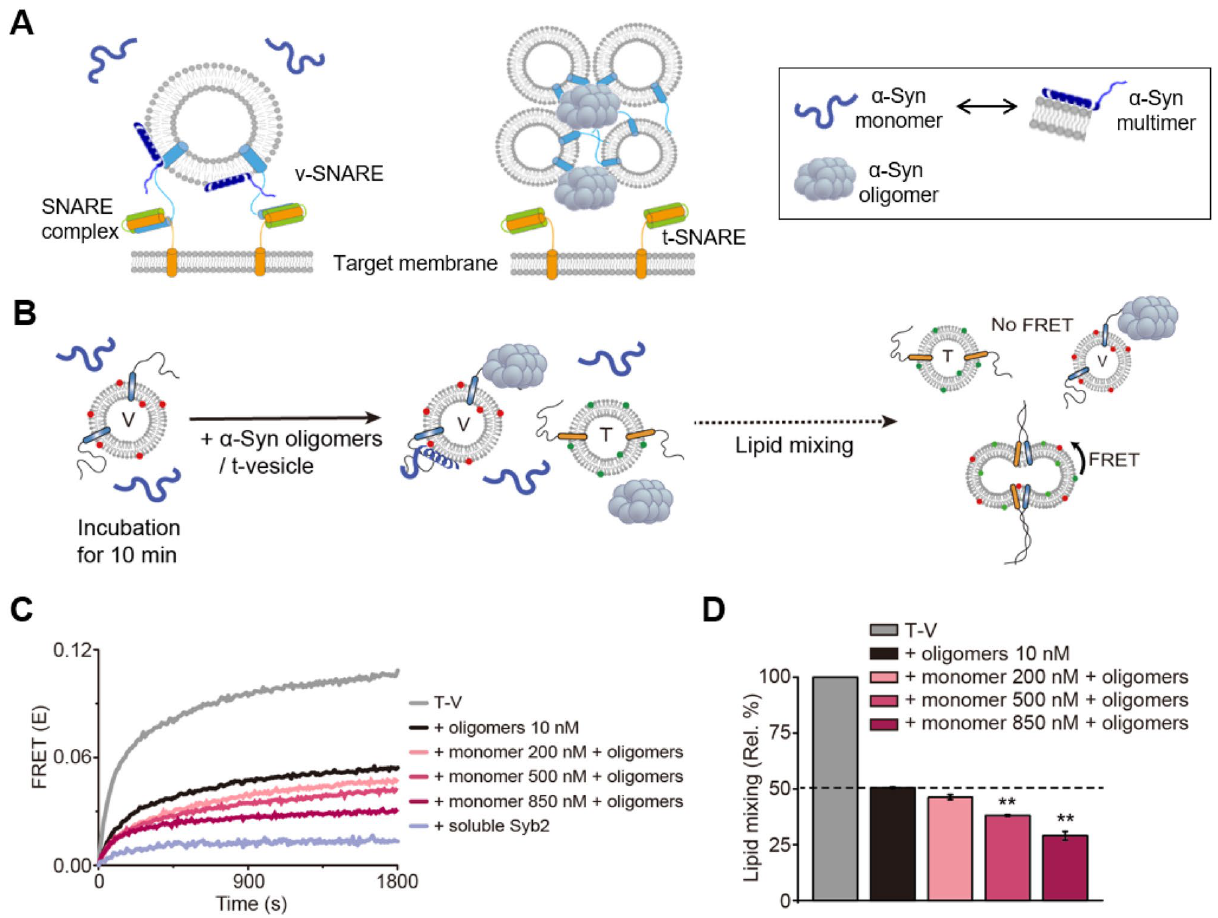
Figure 1. Cooperative inhibition of SNARE-mediated membrane fusion by α-Syn monomer and oligomers. ( A ) Mechanistic models of α-Syn monomer and oligomer actions in SNARE-mediated membrane fusion. (Left panel) α-Syn multimers bind to the N-terminal domain of vesicular SNARE (v-SNARE) using its C-terminal domain, which promotes SNARE complex formation. (Right panel) Using the same binding mode, α-Syn oligomers inhibit SNARE-mediated vesicle fusion. ( B ) Scheme of the in vitro lipid-mixing assay. v-Vesicles (V) were incubated with α-Syn monomer for 10 min, and then oligomers and t-vesicles (T) were added to the premixture. These Figures were produced by Adobe illustrator CS6 (Adobe, San Jose, California, USA) (https:// www. adobe. com/ kr/ produ cts/ illus trator. html) and edited by Microsoft Powerpoint professional plus 2019 (Microsoft, Redmond, Washington, USA). ( C ) Cooperative inhibition of vesicle fusion by α-Syn monomer and oligomers (a representative graph showing a FRET change). T and V (20 μM lipid concentration) were mixed together at 37 °C without α-Syn (T-V, gray line). With the addition of α-Syn oligomers (10 nM), a significant reduction in fusion efficiency was observed (the black line). When α-Syn monomer was added to the T–V mixture together with oligomers, the FRET signal was lower than that of the α-Syn oligomer-treated vesicle fusion. Lipid mixing was confirmed to be driven by SNARE complex formation by the addition of the soluble domain of Syb2, which blocked lipid mixing (the light purple line). ( D ) Relative percentages of lipid mixing at 1800s from the FRET data in ( C ) (± SEM, N = 3; three measurements were performed in different days). **P < 0.01 by ANOVA test. The graphs shown were produced using Originlab 8.5 software (OriginLab Corporation, Northhampton, MA, USA) (https:// www. origi nlab. com/ index. aspx? go = PRODUCTS/Origin) and edited by Adobe Illustrator CS6